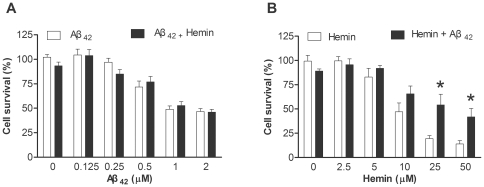
Effects of Aβ on hemin induced cytotoxicity.
A) Differentiated neuroblastoma cells, SH-SY5Y, were treated with different doses of pre-incubated Aβ1–42 without (open bars) or with 0.25 µM of hemin (closed bars). B) Differentiated SH-SY5Y cells were treated with different doses of hemin without (open bars) or with 0.25 µM of pre-incubated Aβ1–42 (closed bars). The cell viability was determined by MTT reduction assay. Bonferroni's post-hoc test: * p<0.05 vs. respective hemin group.